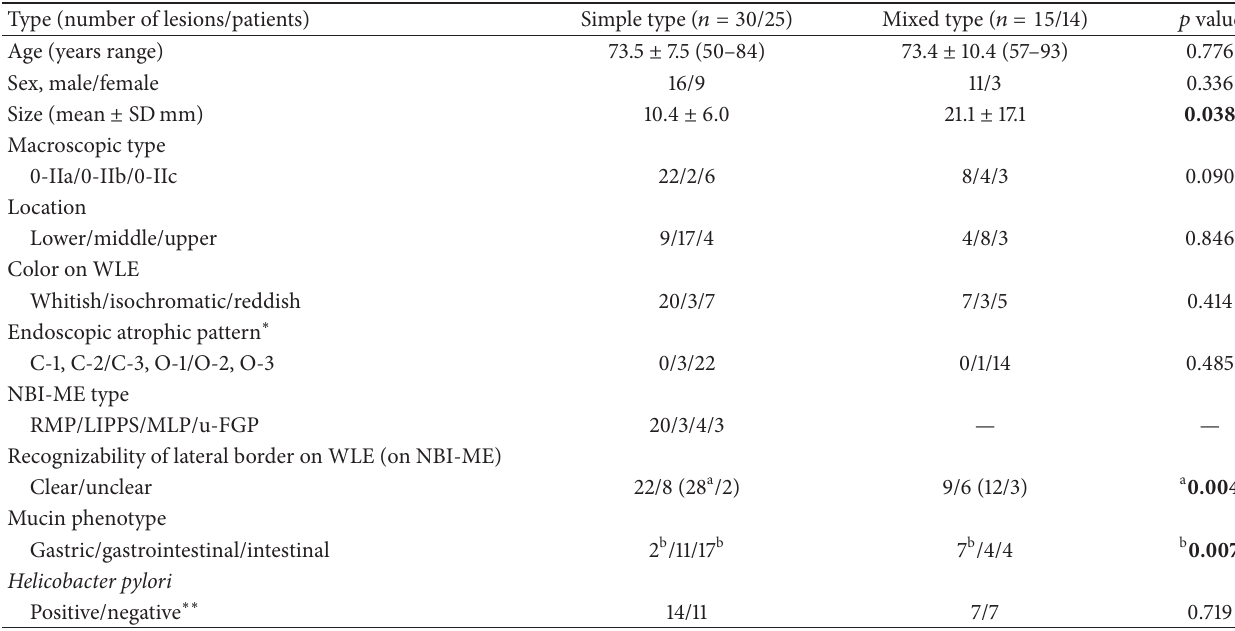
Table 3: Patient characteristics.